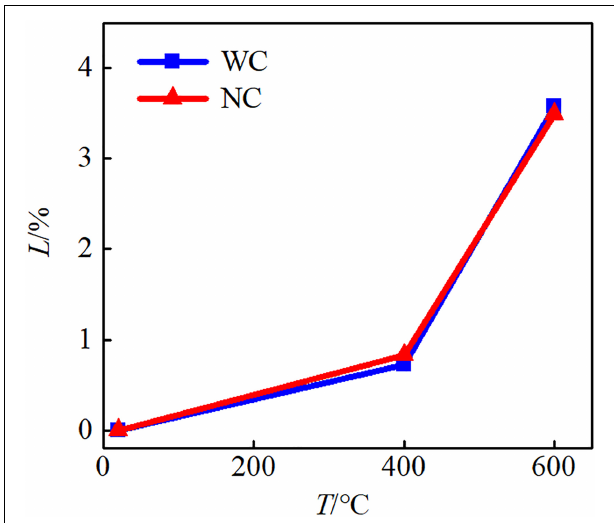
FIGURE 3 | The mass loss rate of specimens.